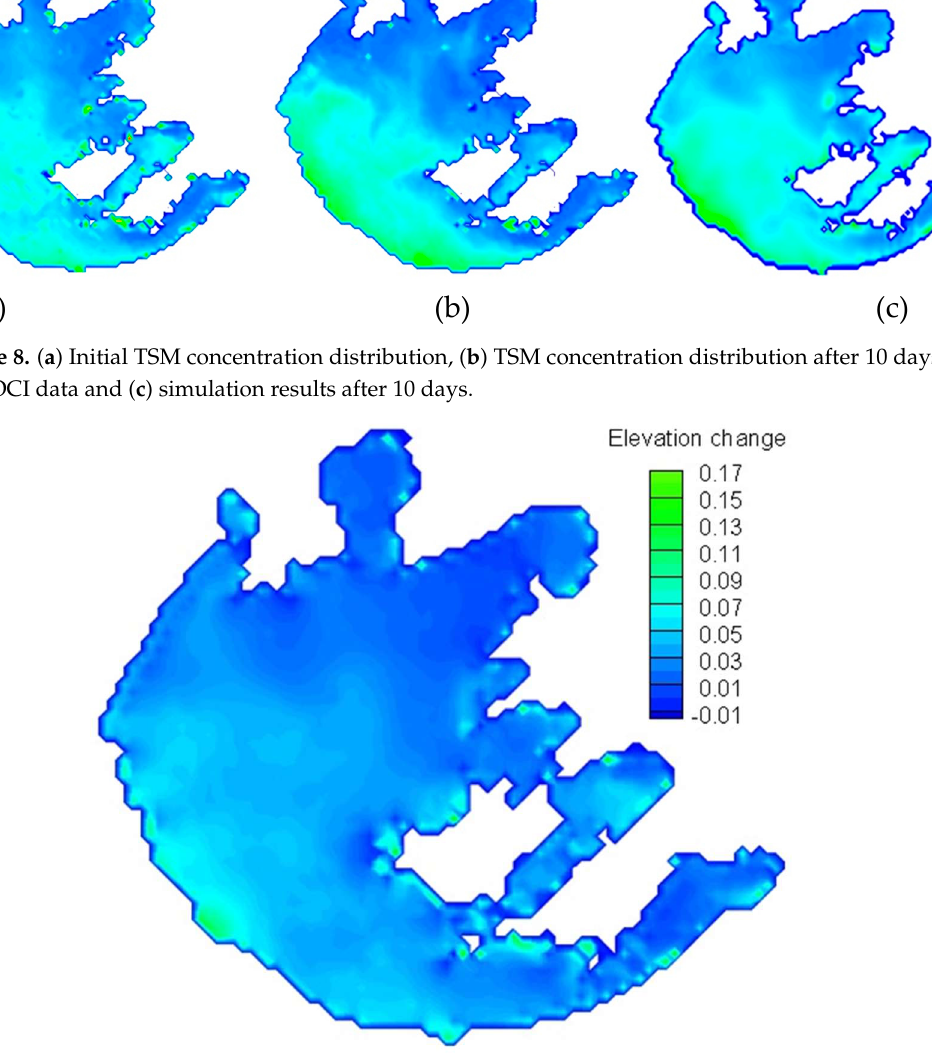
Figure 9. Change of bed elevation.